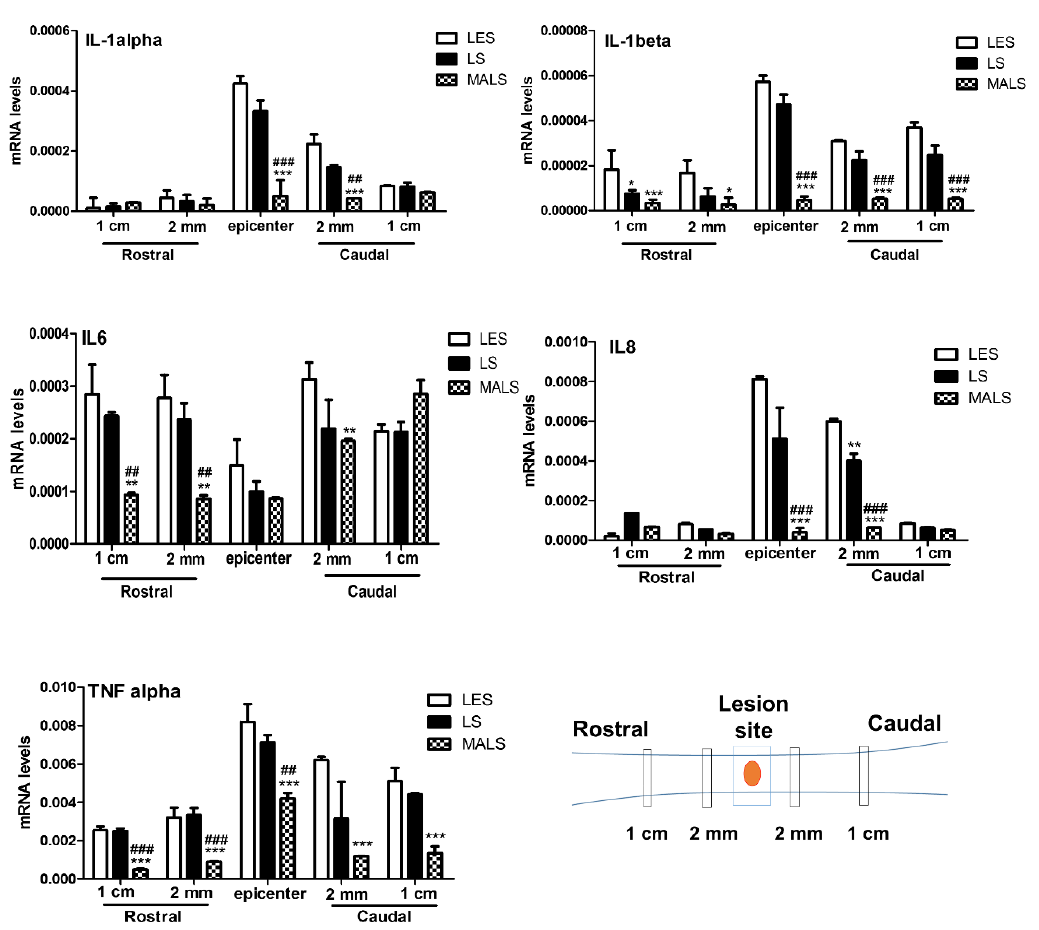
Figure 1. MALS tissue administration reduces the expression of pro-inflammatory cytokines. 35 days after transplantation, mRNA levels of IL-1 alpha, IL-1 beta, TNF-alpha, IL-6 and IL-8 were quantified at the lesion epicenter and 2 mm and 1 cm caudal and rostral to the lesion site of animals transplanted with Mechanically activated lipoaspirate (MALS), or with lipoaspirated tissue (LS) or in lesioned non-